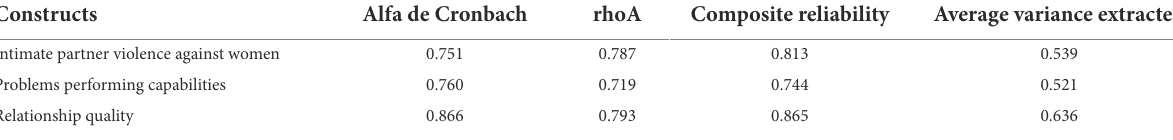
TABLE 1 Reliability and validity of the constructs.